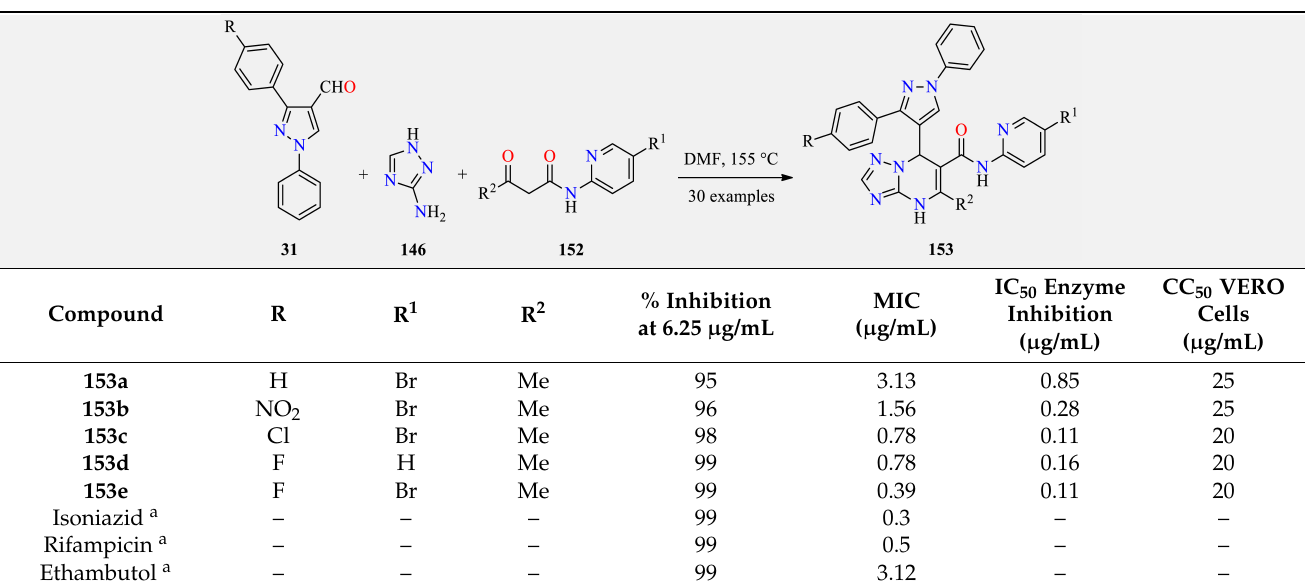
Table 49. Three-component synthesis of pyrazole-linked triazolo[1,5- a ]pyrimidines 153 as anti- tubercular agents.